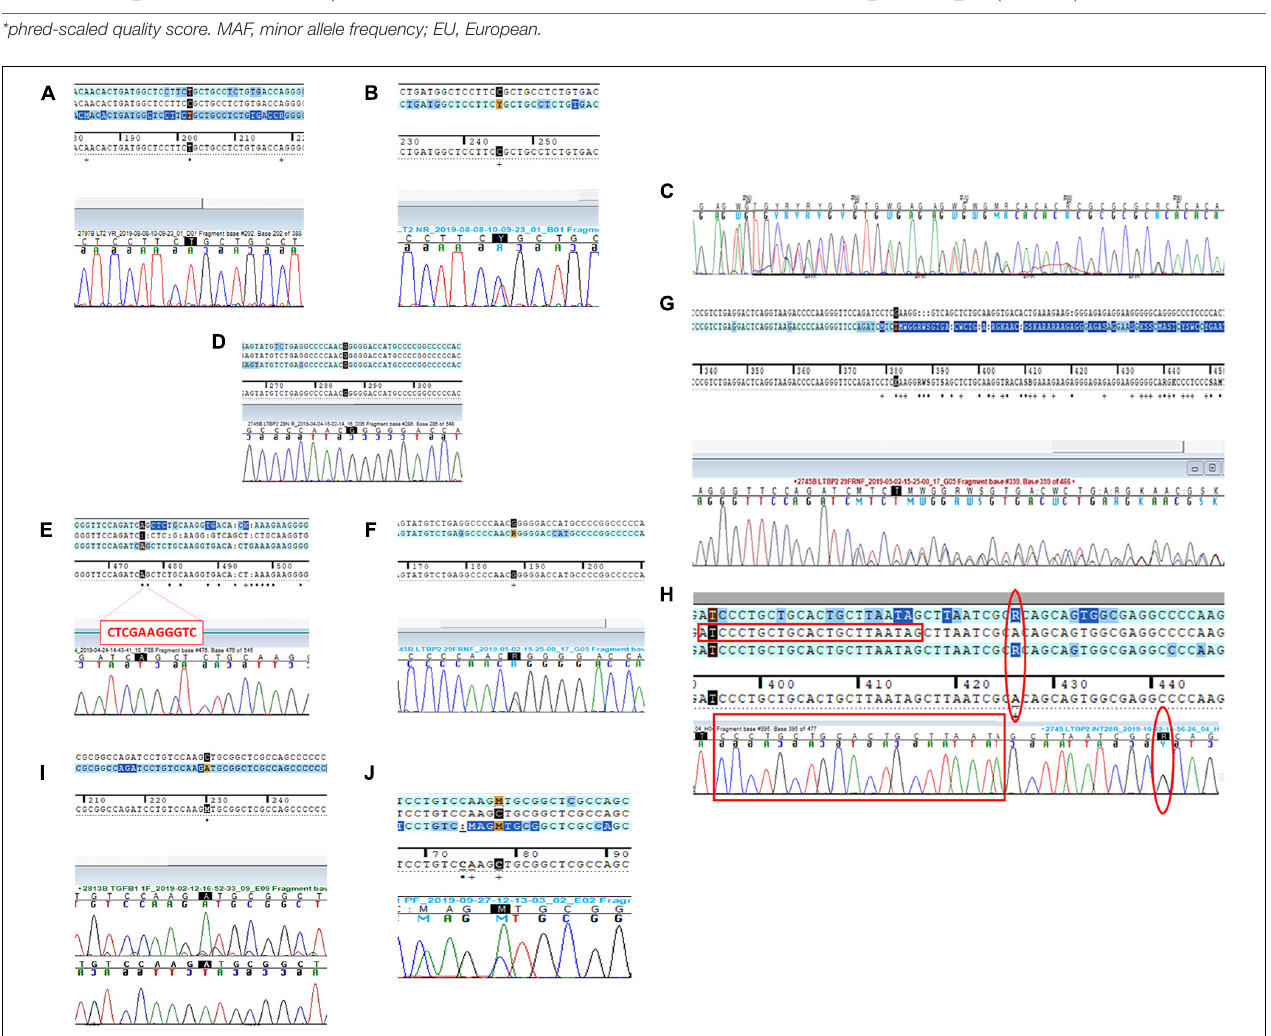
FIGURE 1 | Direct sequencing electropherograms of the genetic variants in (A) LTBP2 (P1), original primers; (B) LTBP2 (P1), new primers; (C) LTBP2 deletion (P1), new primers; (D) LTBP2 point mutation (P2), original primers; (E) LTBP2 deletion (P2), original primers; (F) LTBP2 point mutation (P2), second F primer + original R primer; (G) LTBP2 deletion (P2), second F primer + original R primer; (H) LTBP2 (P2) intronic primers (the empty red rectangles indicate the original F primer sequence; the empty red circles indicate the rs11846588 SNP proximal to the 3 (cid:48) primer end); (I) TGFB1 (P3), original primers; and (J) TGFB1 (P3), new